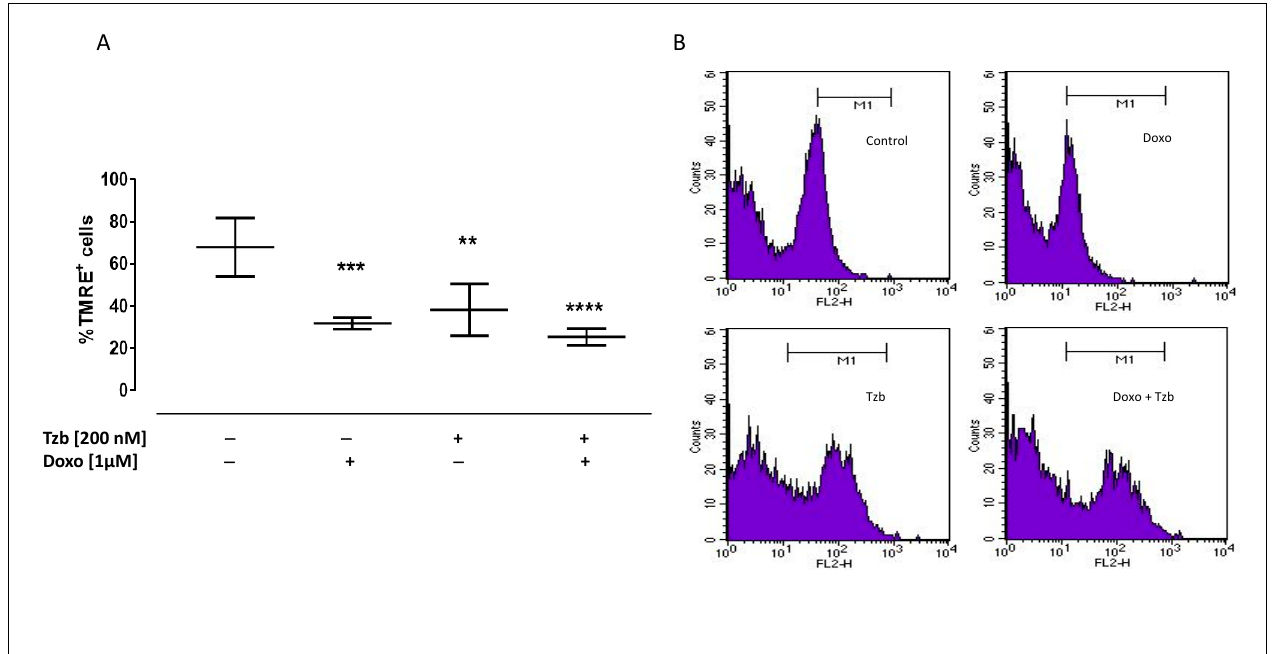
Figure 2. Doxo and Tzb and their association effect on mitochondrial membrane depolarization. Doxo (1 µ M) was administered for 4 h, and Tzb (200 nM) was administered for 20 h. Mitochondrial membrane potential was evaluated by flow cytometry analysis with Tetramethylrhodamine ethyl ester (TMRE), a cell permeant, positively charged, red-orange dye, which comes in and accumulates in the mitochondria in inverse proportion to the membrane potential. The low value of TMRE+ cells percentage means indicates that the TMRE dye was not trapped in the mitochondrial membrane due to its depolarization. Results are expressed as mean ± S.E.M. of fluorescence intensity of at least three independent experiments, each performed in duplicate ( A ). Data were analysed by variance test analysis, and multiple comparisons were made by Bonferroni’s test. ** p < 0.005, *** p < 0.001 and **** p < 0.0001 vs. non-treated cells. Panels ( B ) reports representative histograms for the flow cytometry